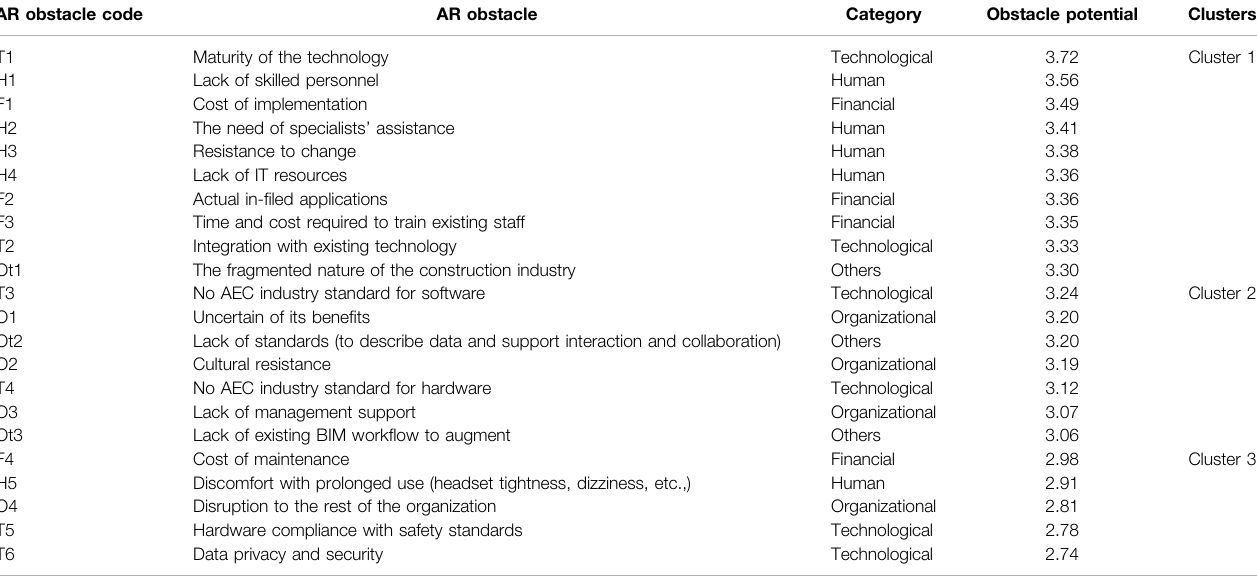
TABLE 3 | Clustered table of AR obstacles. AR obstacle